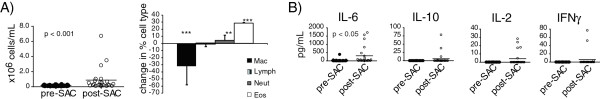
Segmental allergen challenge (SAC) induces an inflammatory response detected in the BAL fluid of atopic asthmatics. In A), total cell counts and differential analysis are presented for BAL fluid obtained pre- and post-SAC. In B), cytokine levels in the BAL fluid were measured by multiplex ELISA using the Cytokine Bead Array (CBA). Shown is the re-analysis performed on the 24 subjects enrolled in the randomized, placebo controlled, double blinded Costimulation Inhibition of Asthma (CIA) trial at pre-randomization. In A (right panel), the average (change in percent cell type) is presented with error bars representing ± the standard deviation with an (* = p < 0.05; ** = p <0.01; *** = p < 0.001). Each subject is represented by a single circle in the graphs with p values presented. Due to pre-SAC cytokines being below the detection limit of the assay (5 pg/mL), no statistical analysis was performed for IL-10, IL-2 or IFN-γ.